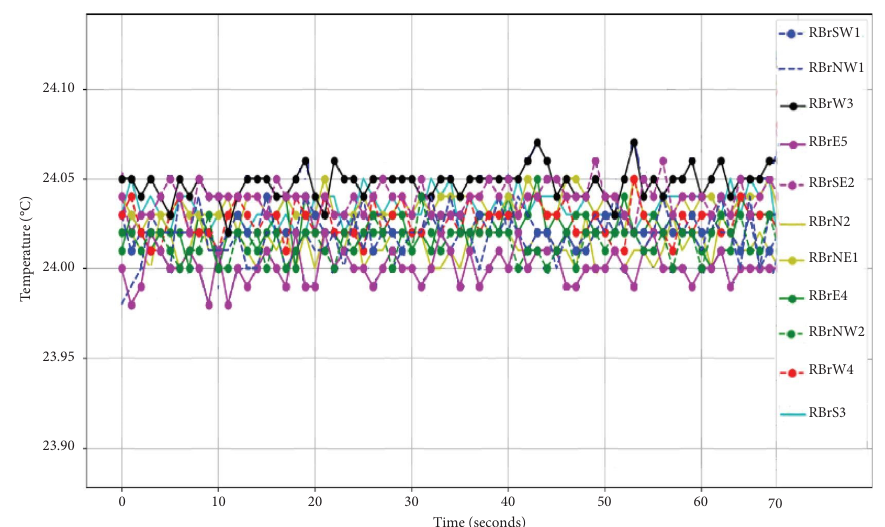
Figure 13: Temperature variation in several bioheat microsensors for the normal